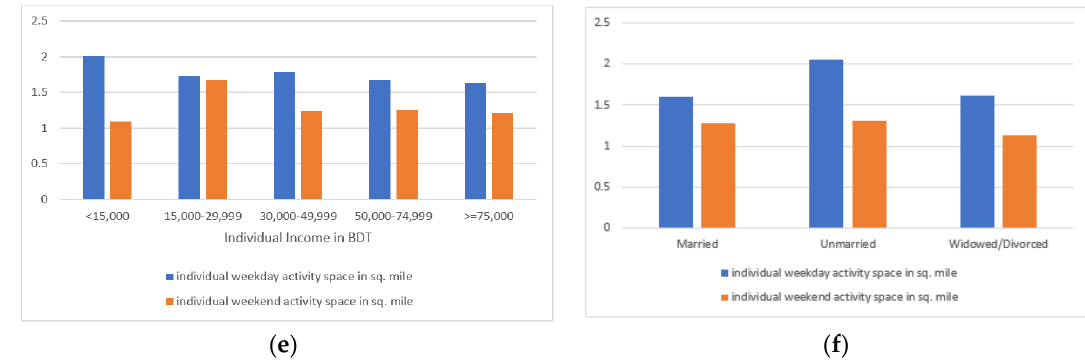
Figure 17. The weekday-to-weekend variability of individual activity space indices. USD 1 is equivalent to BDT 84.77 (Bangladeshi Taka) as of July 7, 2020. ( a ) AS values by gender; ( b ) AS values by age; ( c ) AS values by education level; ( d ) AS values by employment status; ( e ) AS values by individual income level; ( f ) AS values by marital status.